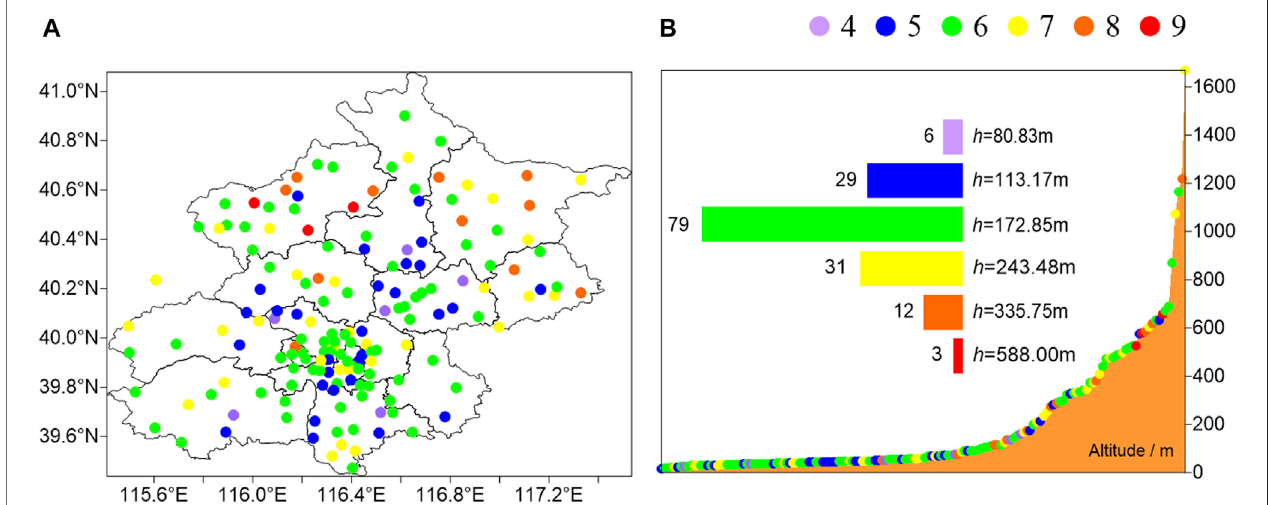
FIGURE 5 | (A) Spatial distribution oftypical cluster numbers at different stations. (B) Relationship between the typical cluster number and the station altitude. The orange contour representsthestation altitude,thescatterchartrepresentstheclusternumber ofthecorrespondingstation, and thehistogramisthenumber ofdifferent clusters and the average altitude of the number. The x -axis represents the stations, and the y -axis represents these stations ’ altitude.